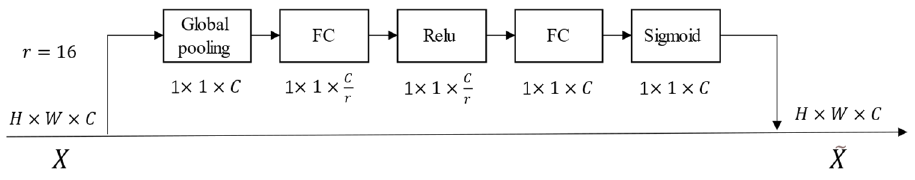
Figure 8. The channel attention mechanism structure: SE block.